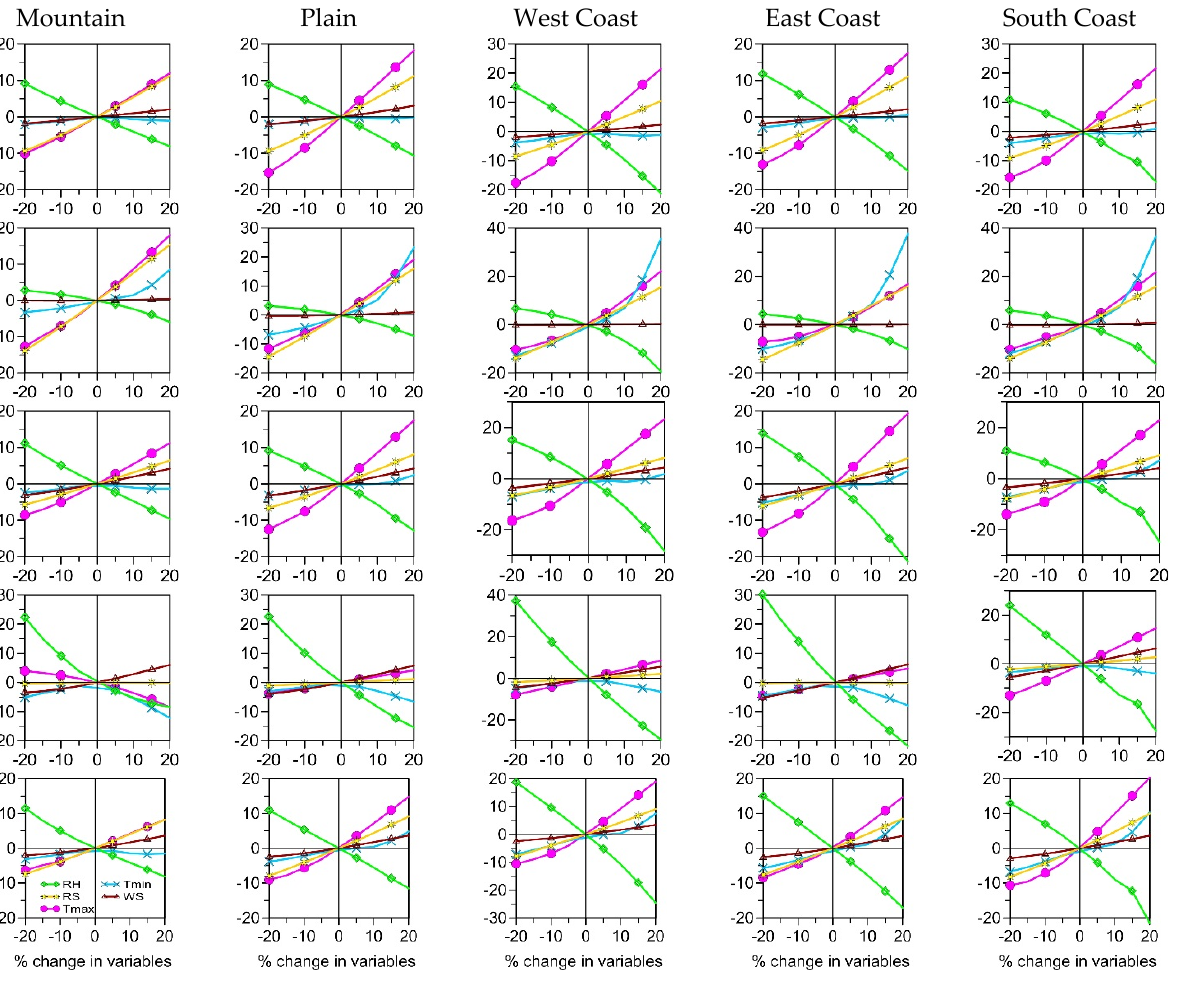
Figure 6. Relative change in ET (cid:2925) with respect to the percent change of meteorological variables on seasonal and annual scales in different geographic conditions.